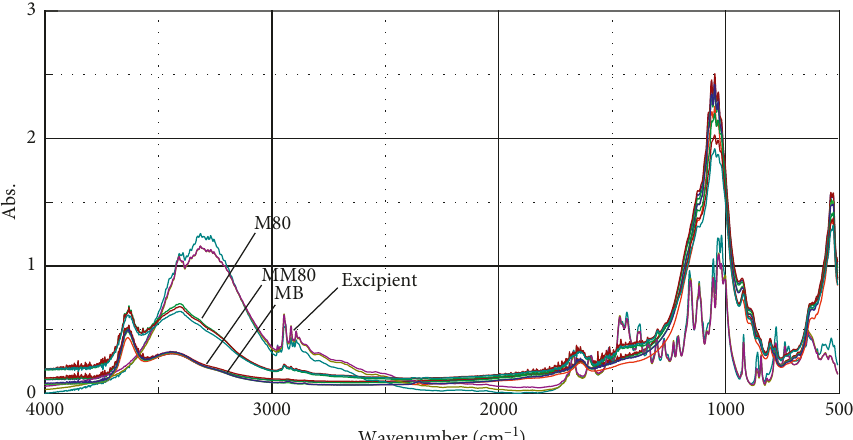
Figure 4: FT-IR spectra of mineralized bentonite (MB) and mineralized mixture 80% (MM80) versus those of nonmineralized mixture 80% (M80) and excipients.